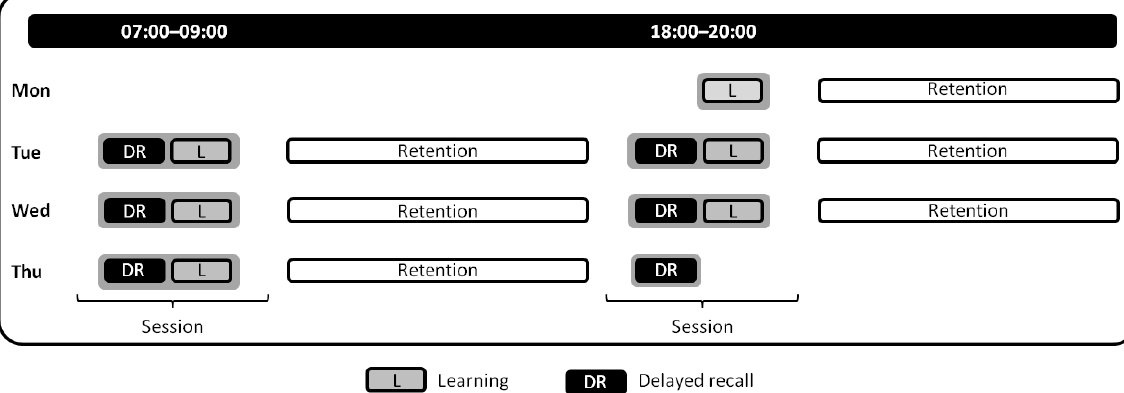
Figure 1. Visual representation of the study protocol. The figure illustrates the study protocol specifically for the procedural memory task (for an overview of the full study protocol including verbal and visuospatial memory tasks, see Supplementary Figure S1). The first session took place on Monday evening and included a learning session of the procedural memory task. All subsequent sessions except for Thursday evening included delayed recall of the previously learned task version and the learning of a new task version.